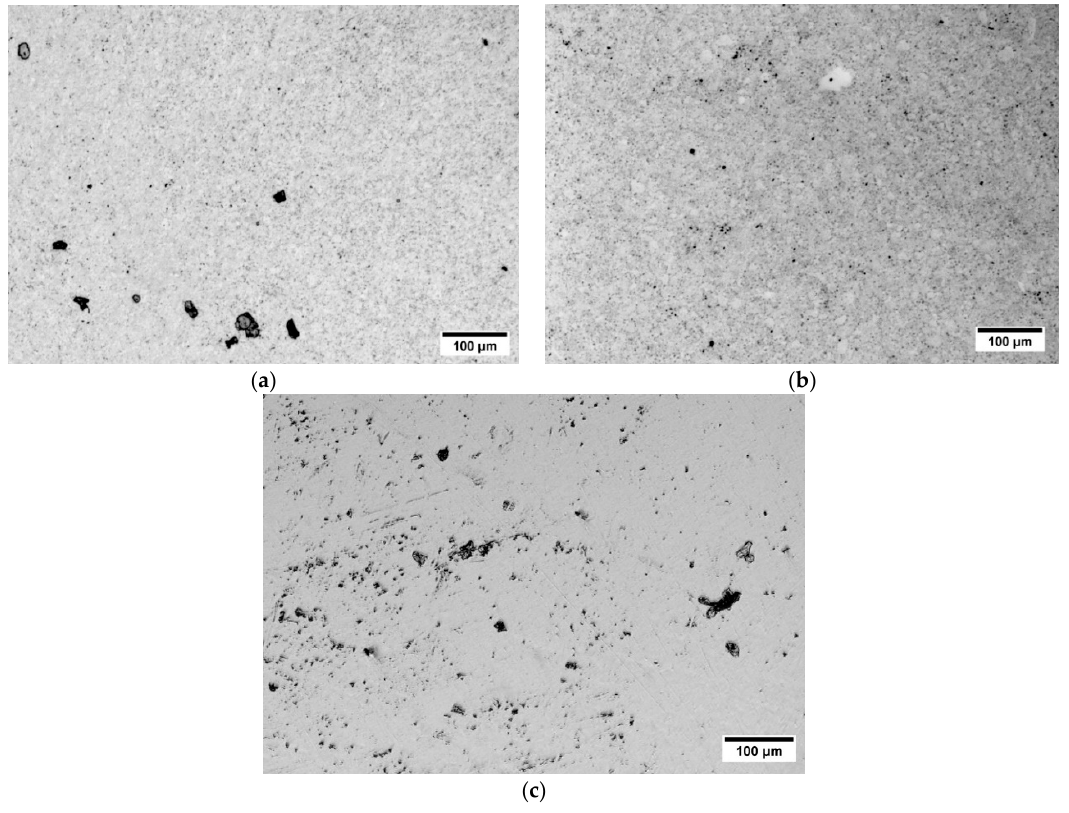
Figure 14. Optical Microscope (OM) images of the surface of specimens: ( a ) as-HIP, ( b ) HIP + HT–FC, and ( c ) 316LV steel after the polarization test in the Hank’s solution.